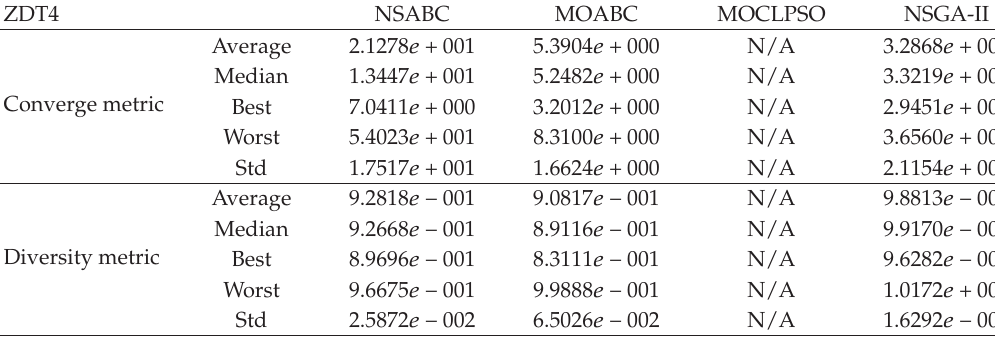
Table 11: Comparison of performance on ZDT4 after 10000